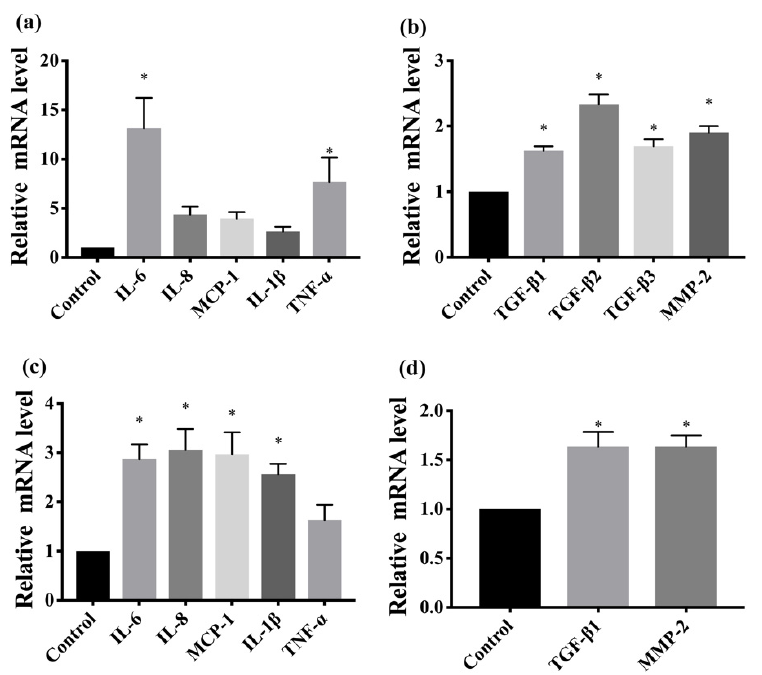
Figure 4. ( a ) Comparison of retinal mRNA expression levels of TNF- α , IL-6, IL-8, MCP-1, and IL-1 β between the FDM7 and CON7 groups.; ( b ) comparison of retinal mRNA expression levels of TGF- β 1, TGF- β 2, TGF- β 3, and MMP2 between the FDM7 and CON7 groups.; ( c ) comparison of retinal mRNA expression levels of TNF- α , IL-6, IL-8, MCP-1, and IL-1 β between the FDM14 and CON14 groups.; ( d ) retinal mRNA expression levels of TGF- β 1 and MMP2 between the FDM14 and CON14 groups. * p < 0.01 (ANOVA).